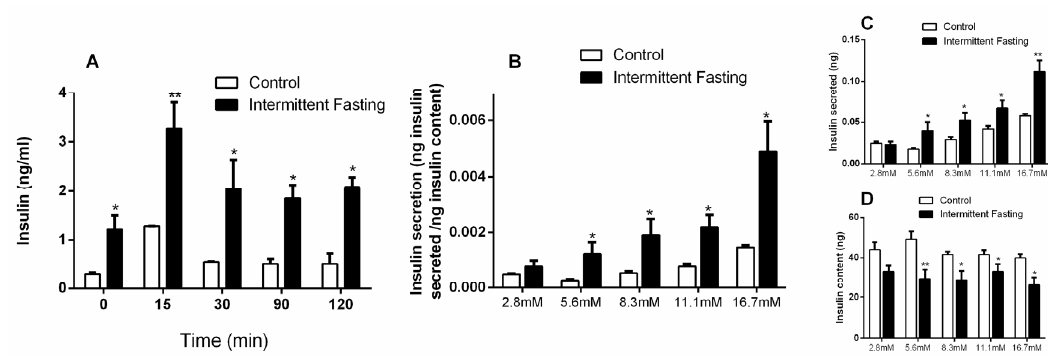
Figure 8. ( A ) Insulin concentrations obtained during oral glucose tolerance tests (oGTT) in Wistar rats submitted to IF for 12 weeks. ( B ) Content-corrected insulin secretion, ( C ) insulin secretion, and ( D ) insulin content values in pancreatic islets isolated from Wistar rats submitted to IF for 12 weeks, after one hour of incubation in the presence of 2.8, 5.6, 8.3, 11.1, and 16.7 mM glucose. The results are presented as the means ± standard error of the mean (SEM) with 5 di ff erent animals for each group. * p < 0.05 and ** p < 0.005 compared to the control at the same time, as indicated by two-way ANOVA followed by Sidak’s multiple comparisons test.